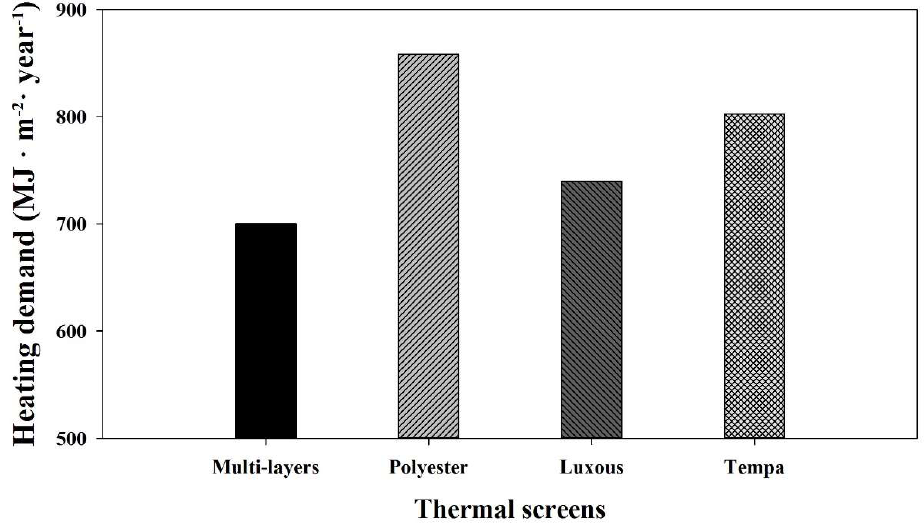
Figure 11. Annual heating demand of different thermal screens.